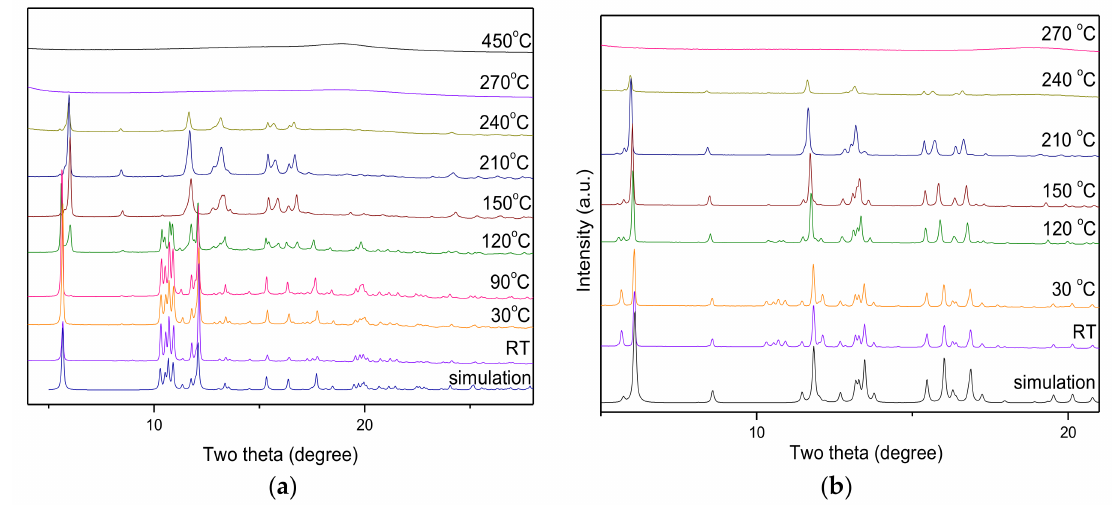
Figure 5. The PXRD patterns at different temperatures for compounds: 1 ( a ), 2 ( b ).